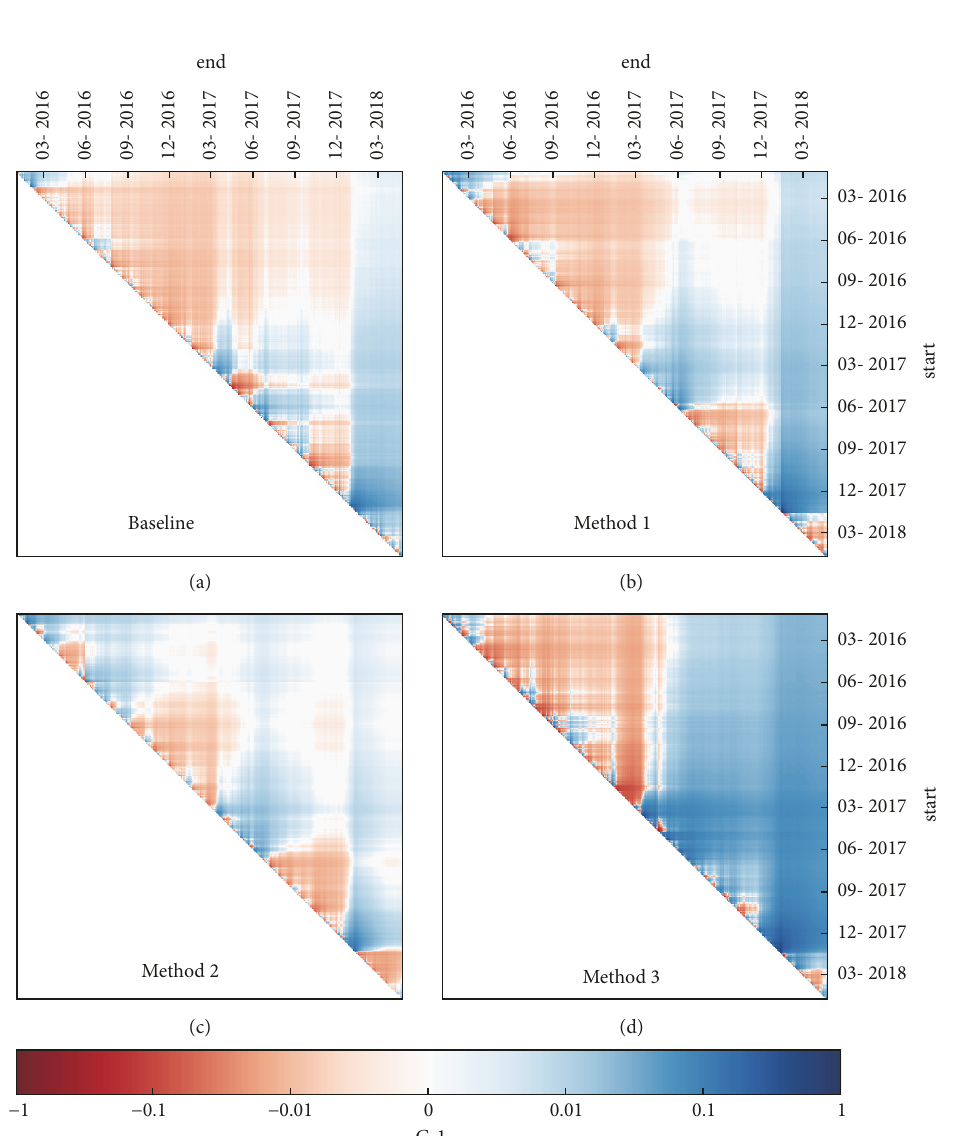
Figure 14: Daily geometric mean return obtained under transaction fees of 0.1 % . The geometric mean return computed between time ”start” and ”end” using the Sharpe ratio optimisation for the baseline (a), Method 1 (b), Method 2 (c), and Method 3 (d). Note that, for visualization purposes, the figure shows the translated geometric mean return G-1. Shades of red refer to negative returns and shades of blue to positive ones (see colour